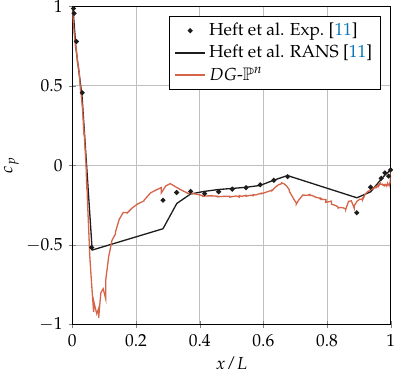
Figure 9. Simplified DrivAer model—Time-averaged pressure coefficient distribution on the symme- try plane for the body ( left ) and underbody ( right ) of the car, low-Reynolds number.